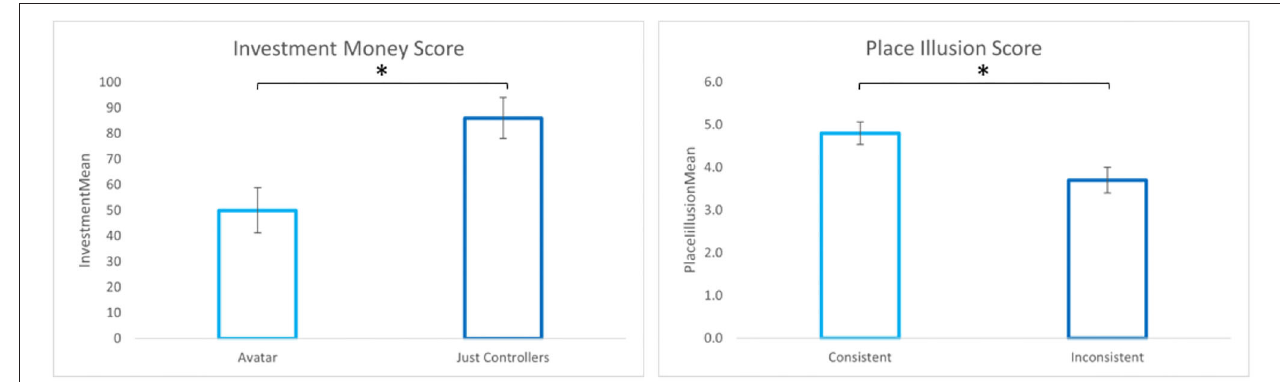
FIGURE 5 | Study 1: bar chart of (Left) conditions where the confederate was without an avatar (just controllers) gained significantly more money, indicating a higher level of trust; (Right) participants reported significant higher level of place illusion in consistent conditions. * p <